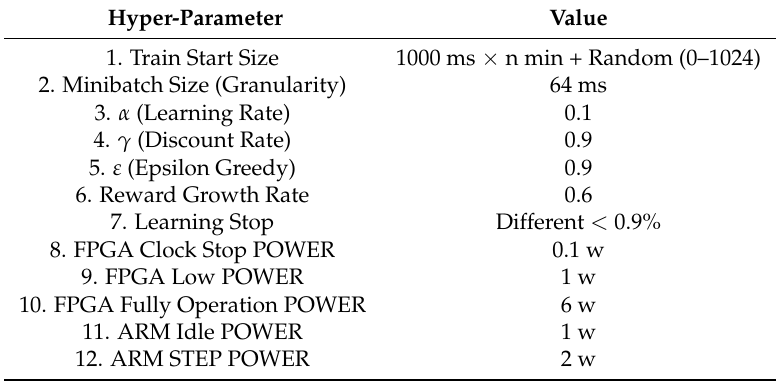
Table 2. PMU-RL algorithm